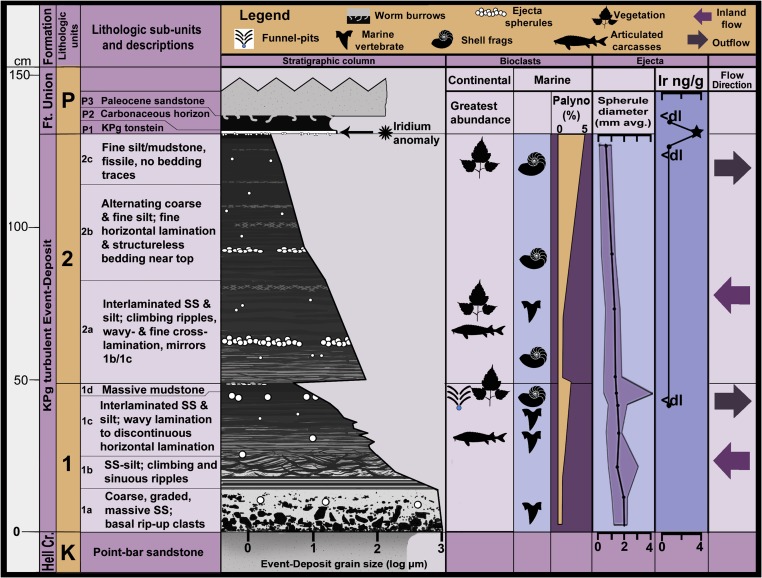
Tanis site stratigraphy and fossil distribution. Stratigraphic section of Tanis, outlining the lithological subdivisions and grain-size profile for the Event Deposit, abundance and primary stratigraphic distribution for a selection of continental and marine fossils, abundance of marine palynomorphs (palyno %), select impact-derived materials, and flow direction.